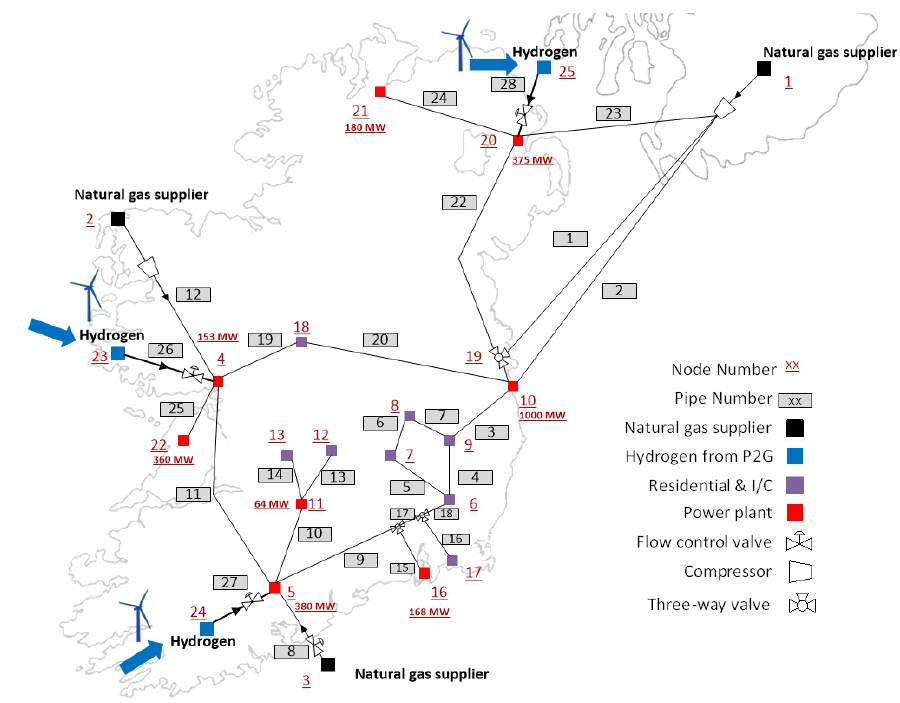
Figure 1. The simplified island of Ireland Gas network with multi P2H interconnection